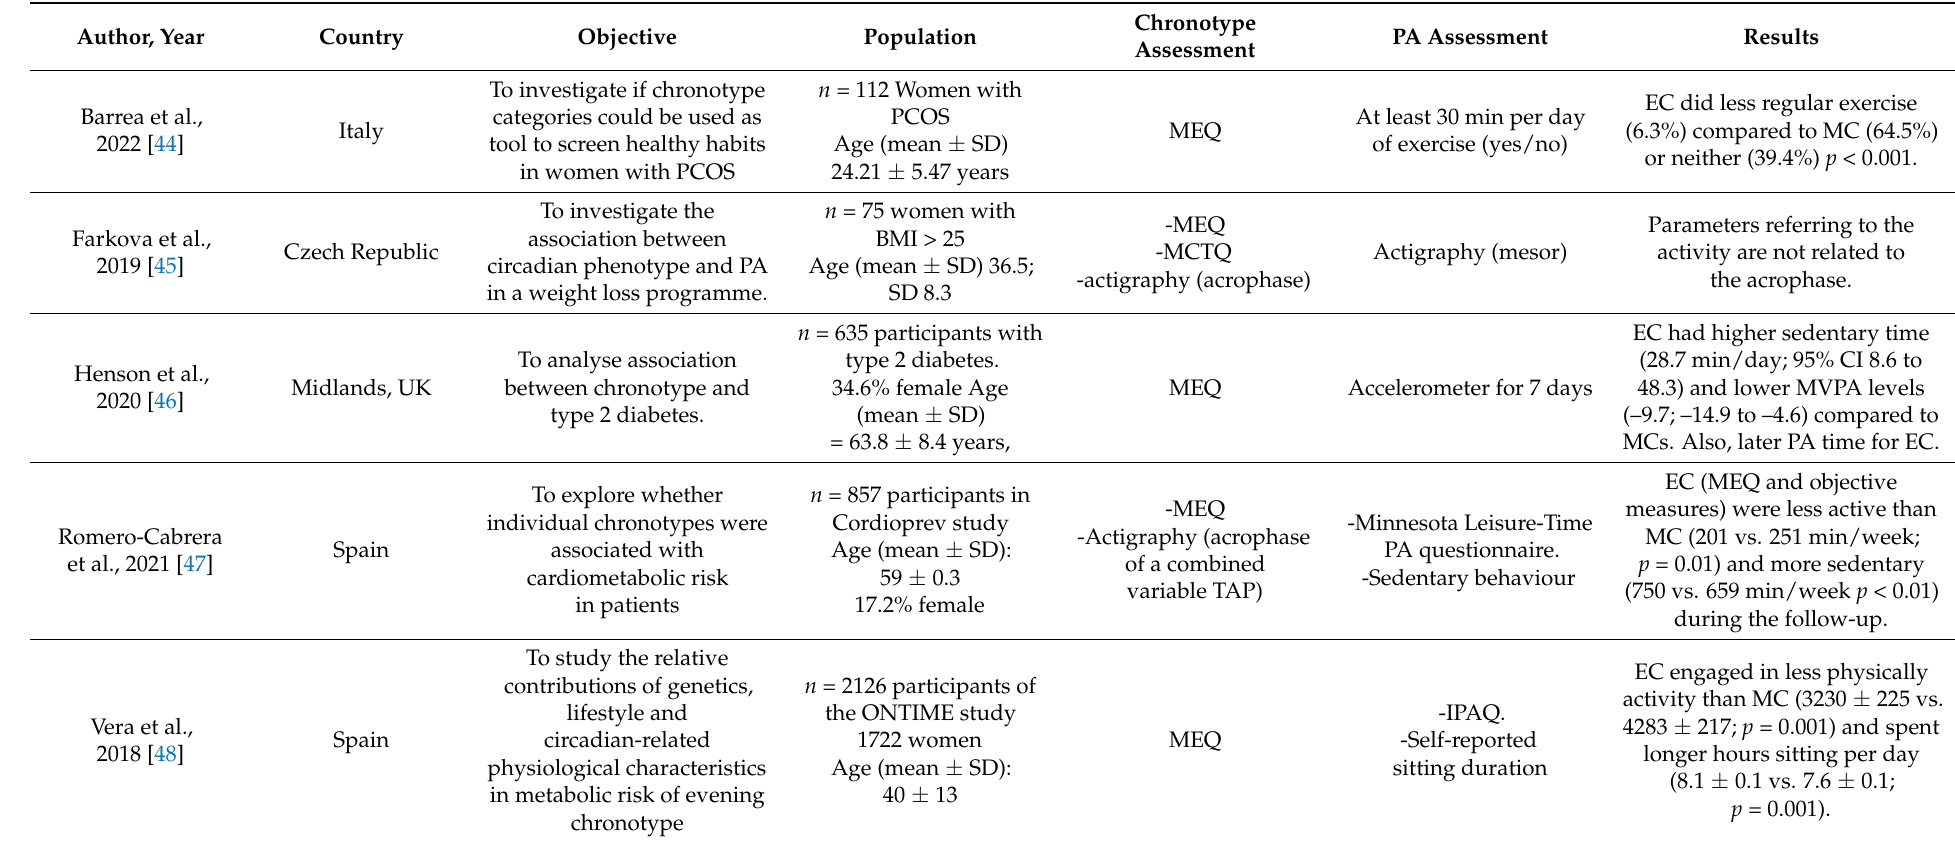
Table 2. Descriptive characteristics of the included studies on specific